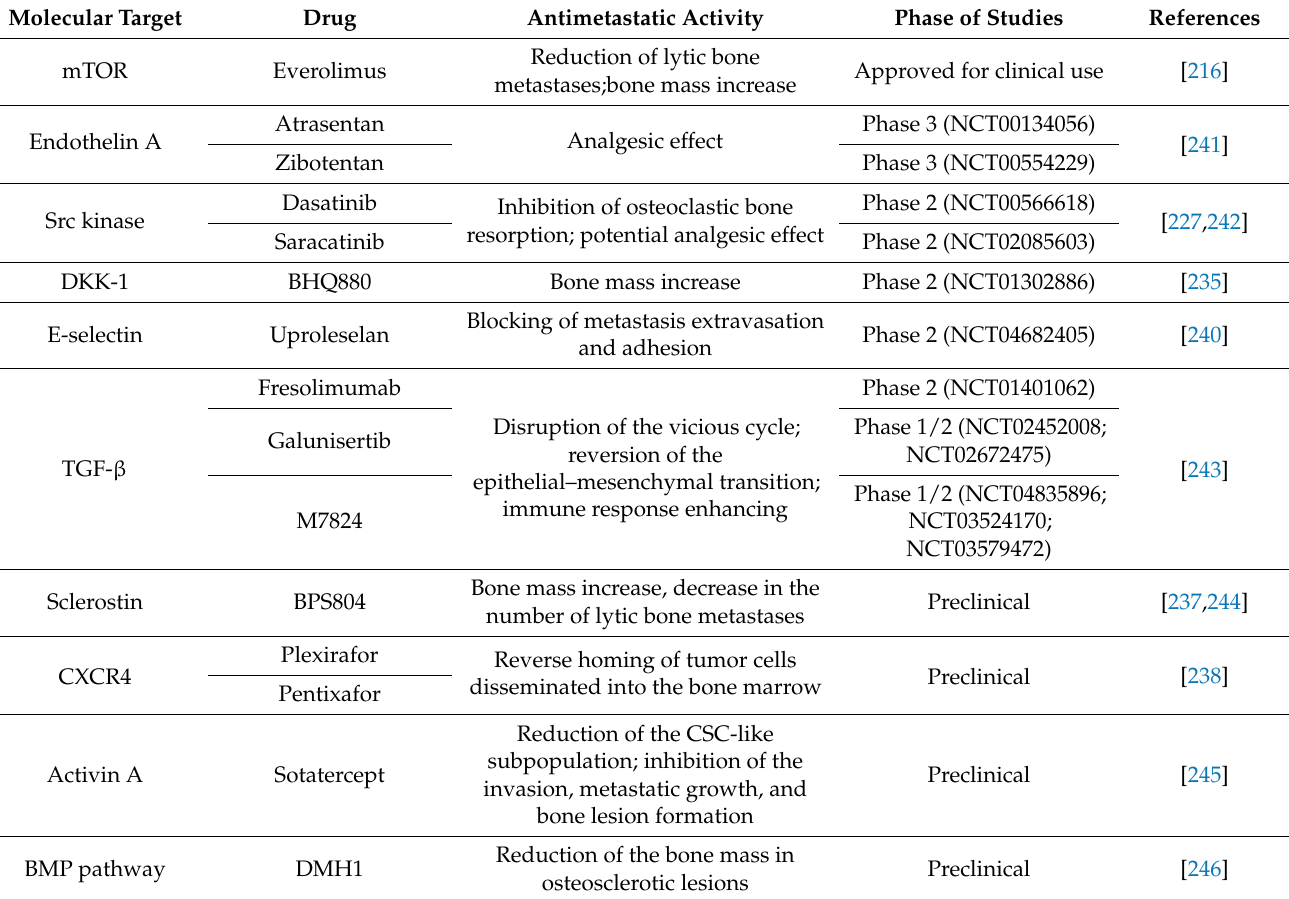
Table 2. The agents for the therapy of bone metastases currently investigated in preclinical and clinical